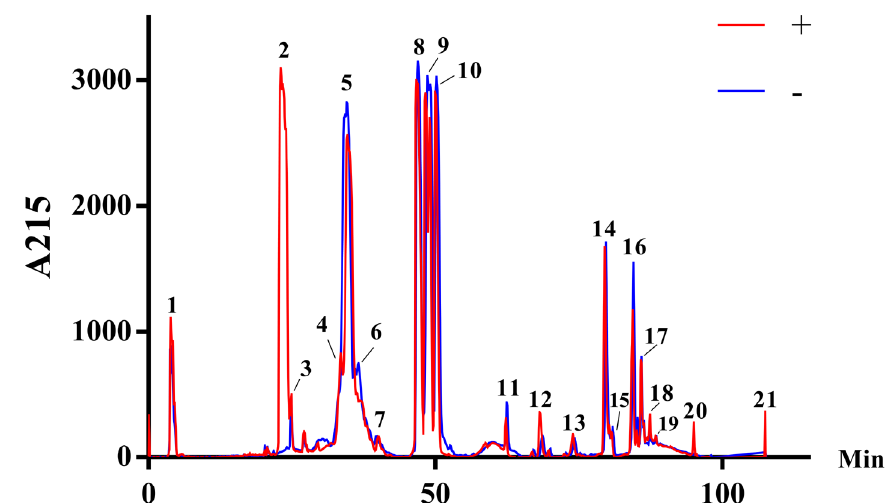
Figure 5. Elution profiles of pools of C. durissus venom by RP-HPLC monitored by 215 nm. Samples of 3 mg of lyophilized venom pools were dissolved in 0.1% trifluoroacetic acid (TFA) (solution A) and subjected to RP-HPLC on a C18 column. Elution was performed at 1.0 mL/min by applying a gradient toward 0.1% TFA and 95% acetonitrile (solution B), as described in the experimental section. Red (+): crotamine-positive venom pool; blue (–): crotamine-negative venom